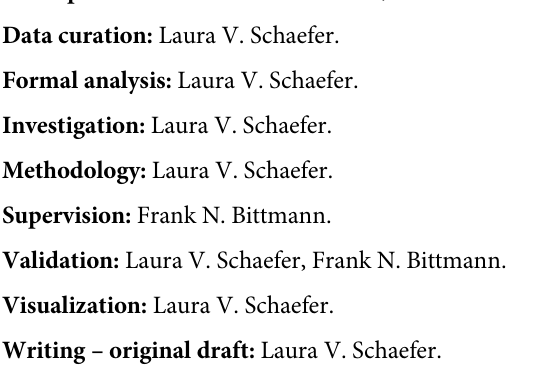
S1 Table. Values of normalized amplitude. S2 Table. Values of mean